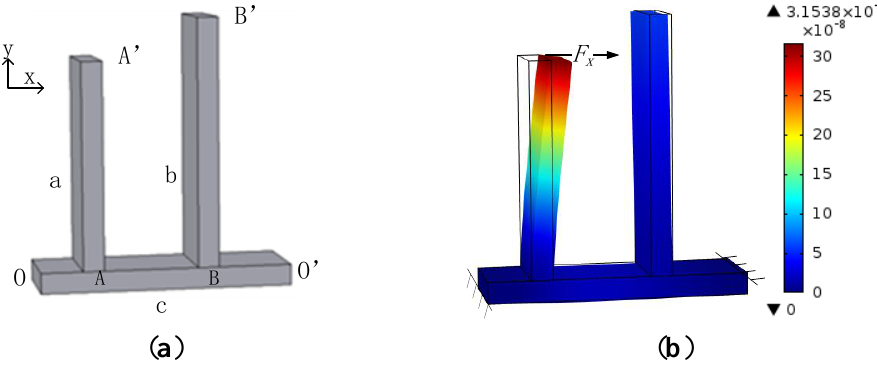
Figure 2. The weak coupling spring system. ( a ) The weak coupling spring system structure; ( b ) Deformation of the spring system when a force is